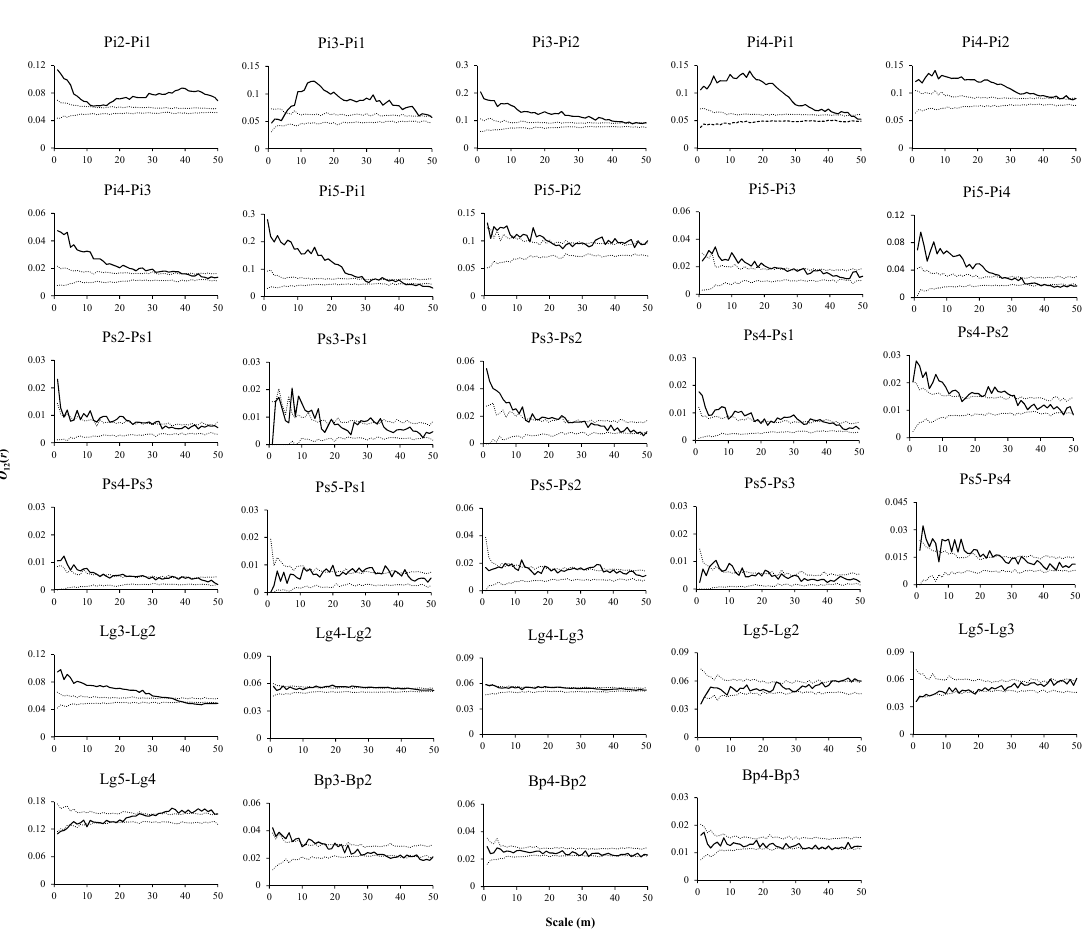
Figure 7. Spatial associations of tree species in CMF.